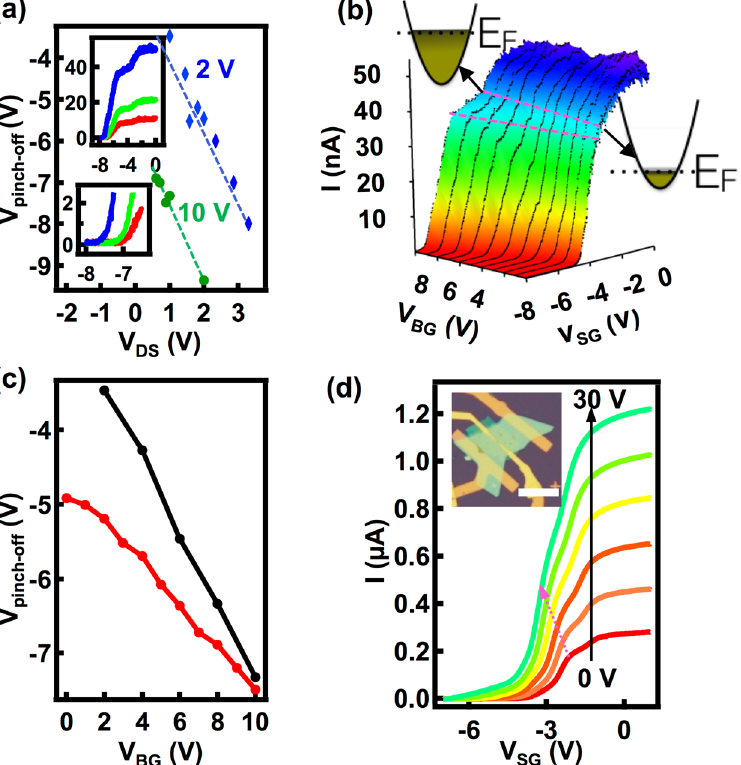
Figure 3. ( a ) Dependence of pinch-off voltage on the drain-source voltage for V BG = 2 V (blue) and 10 V (green) at 4 K. Upper inset: pinch-off curves at three different V DS , 0.61 V (red), 0.72 V (green) and 0.89 V (blue) with V BG = 10 V. x-axis is V SG in Volts and y-axis is the current through the device in nA. Lower inset: an enlarged view of the pinch-off region. ( b ) A surface plot of pinch-off characteristics at 4 K for a series of V BG with the on-state current kept as 50 nA for each trace. The regime-III, the shoulder, enclosed by the pink dashed lines show a shift in the position and a reduction in the span in V SG as V BG is reduced. The illustrations marked by the arrows show the available states for transport at the onset of point-contact formation for higher (V BG = 10 V) and lower (V BG = 0 V) carrier concentrations. ( c ) Variation of the pinch-off voltage with V BG . The red trace represents the pinch-off voltage extracted from ( b ), and the black trace from pinch-off characteristics taken with a V DS of 1 V. ( d ) Pinch-off characteristics for another point-contact device at 300 K for various V BG values. The arrow indicates the linear shift in the position of the shoulder like structure with the V BG . Inset: Optical image of the device, scale bar is 20 μ